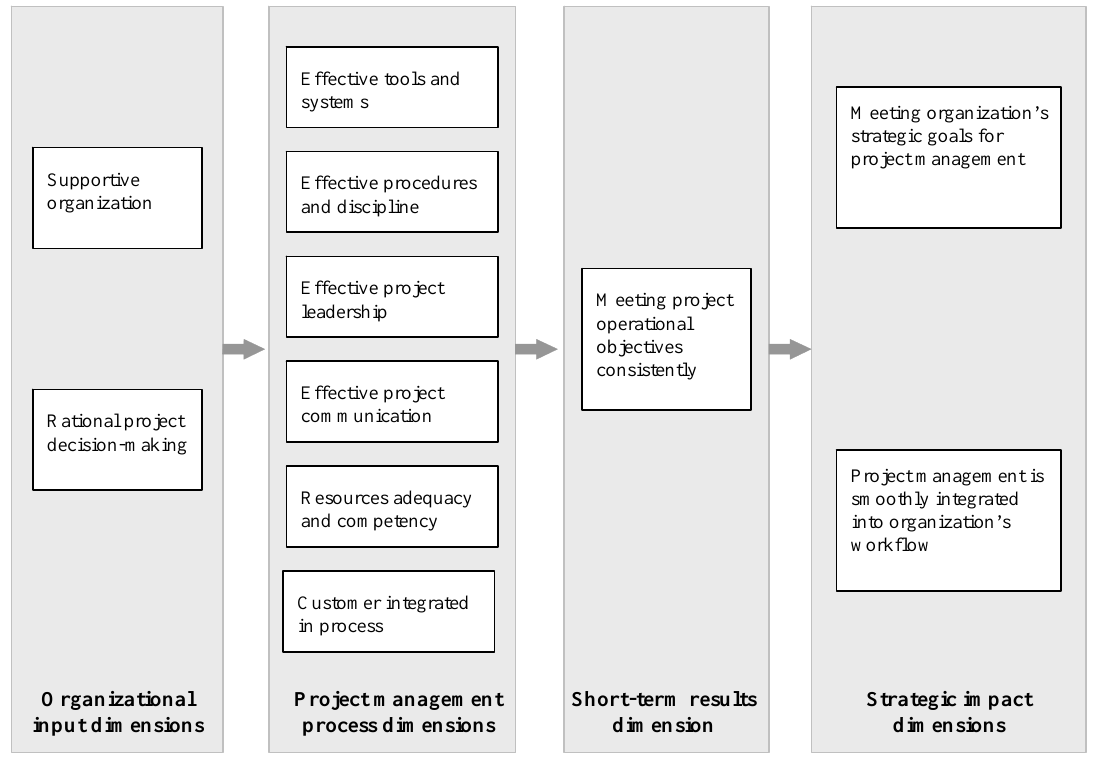
Figure 2: Proposed construct of project management